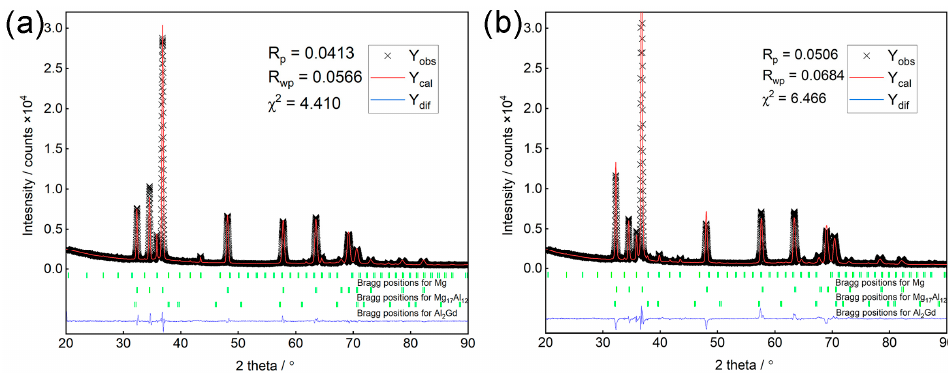
Figure 5. X-ray diffractograms of surfacing alloys: ( a ) AZ91 alloy, ( b ) AZ91 + 0.5 Gd alloy. Table 2. Calculated phase content of surfacing magnesium alloys in volume percentage.